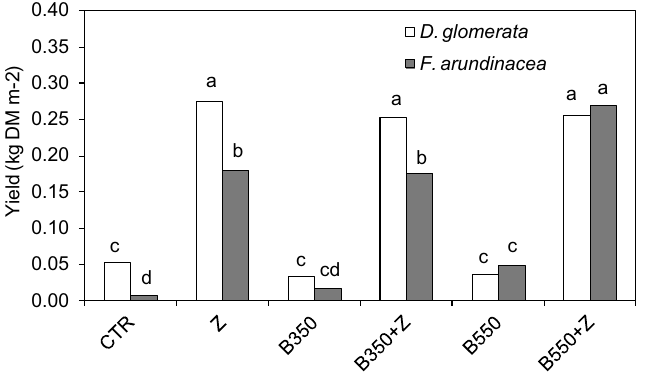
Figure 2. Yields of aboveground biomass of tall fescue ( F. arundinacea ) and cocksfoot ( D. glomerata) . Treatments: zeolite (Z), biochars (B350 and B550), mixtures of biochars and zeolite (B350 + Z and B550 + Z), control (CTR). Different letters on the bars indicate significant differences by the Bonferroni test ( P < 0.05, n =